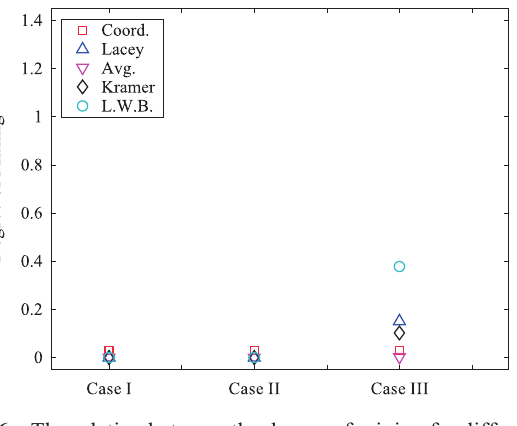
Fig. 6 The relation between the degree of mixing for different kind of mixing indices and different initial configura - tions of black-white particle systems. Total particle number of system is 1728; cell number N is 216; and number of particles (cell size) is n = 8.